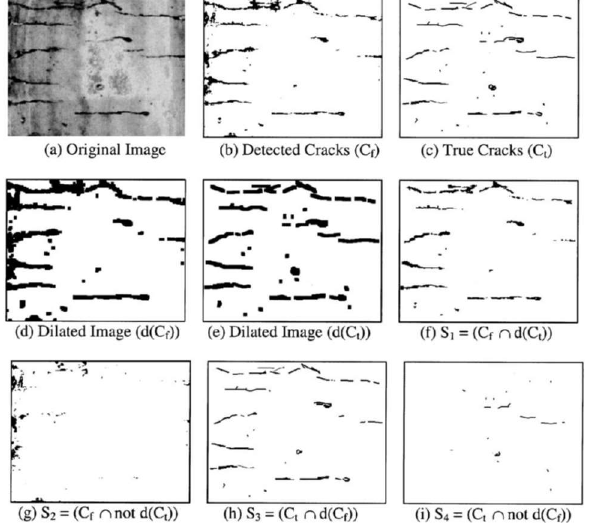
Figure 2: Illustration of the procedure of matching the images for detection of true and false